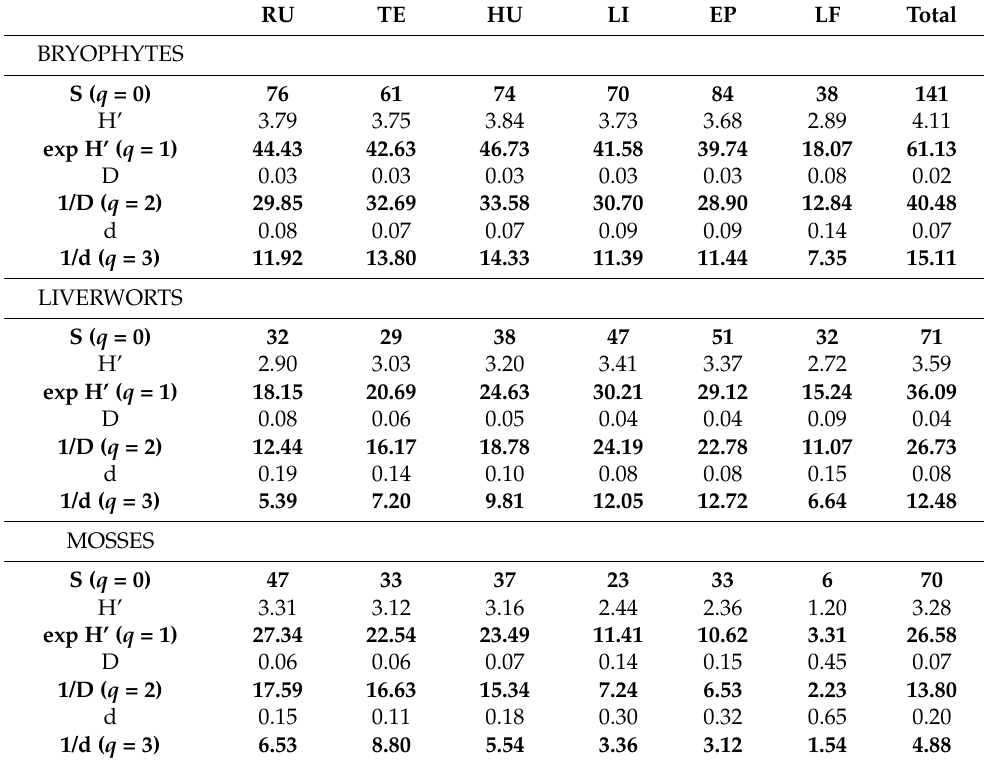
Table 3. Hill numbers for the six substrates collected on the transect of Pico Island (S = richness of species; H’ = Shannon–Wiener index; D = Simpson index; d = Berger–Parker index; RU = rupicolous; TE = terricolous; HU = humicolous; LI = lignicolous; EP = epiphytic; and LF =